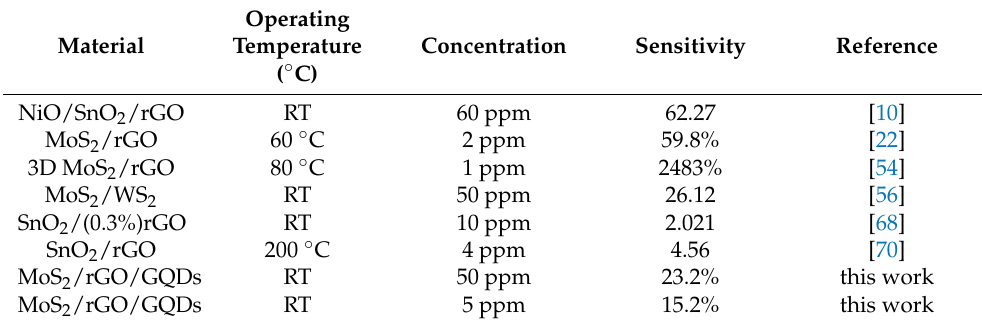
Table 1. Comparison of main properties and performance characteristics of nanomaterials used to detect NO 2 gas.